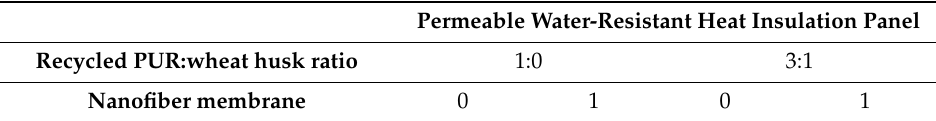
Table 2. Variants of the manufactured sandwich-structured panel.